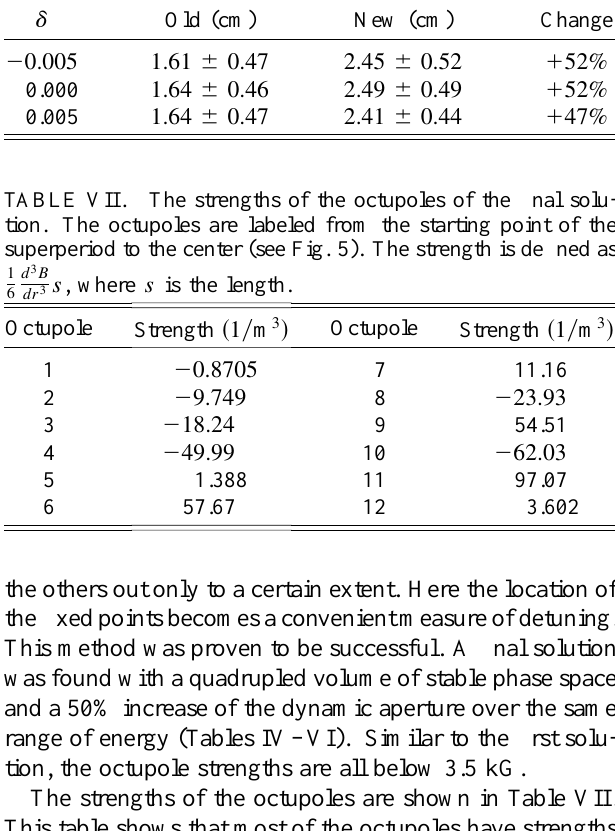
TABLE VI. Dynamic aperture after 12 921 turns: final solu- tion. d Old (cm) New (cm) Change